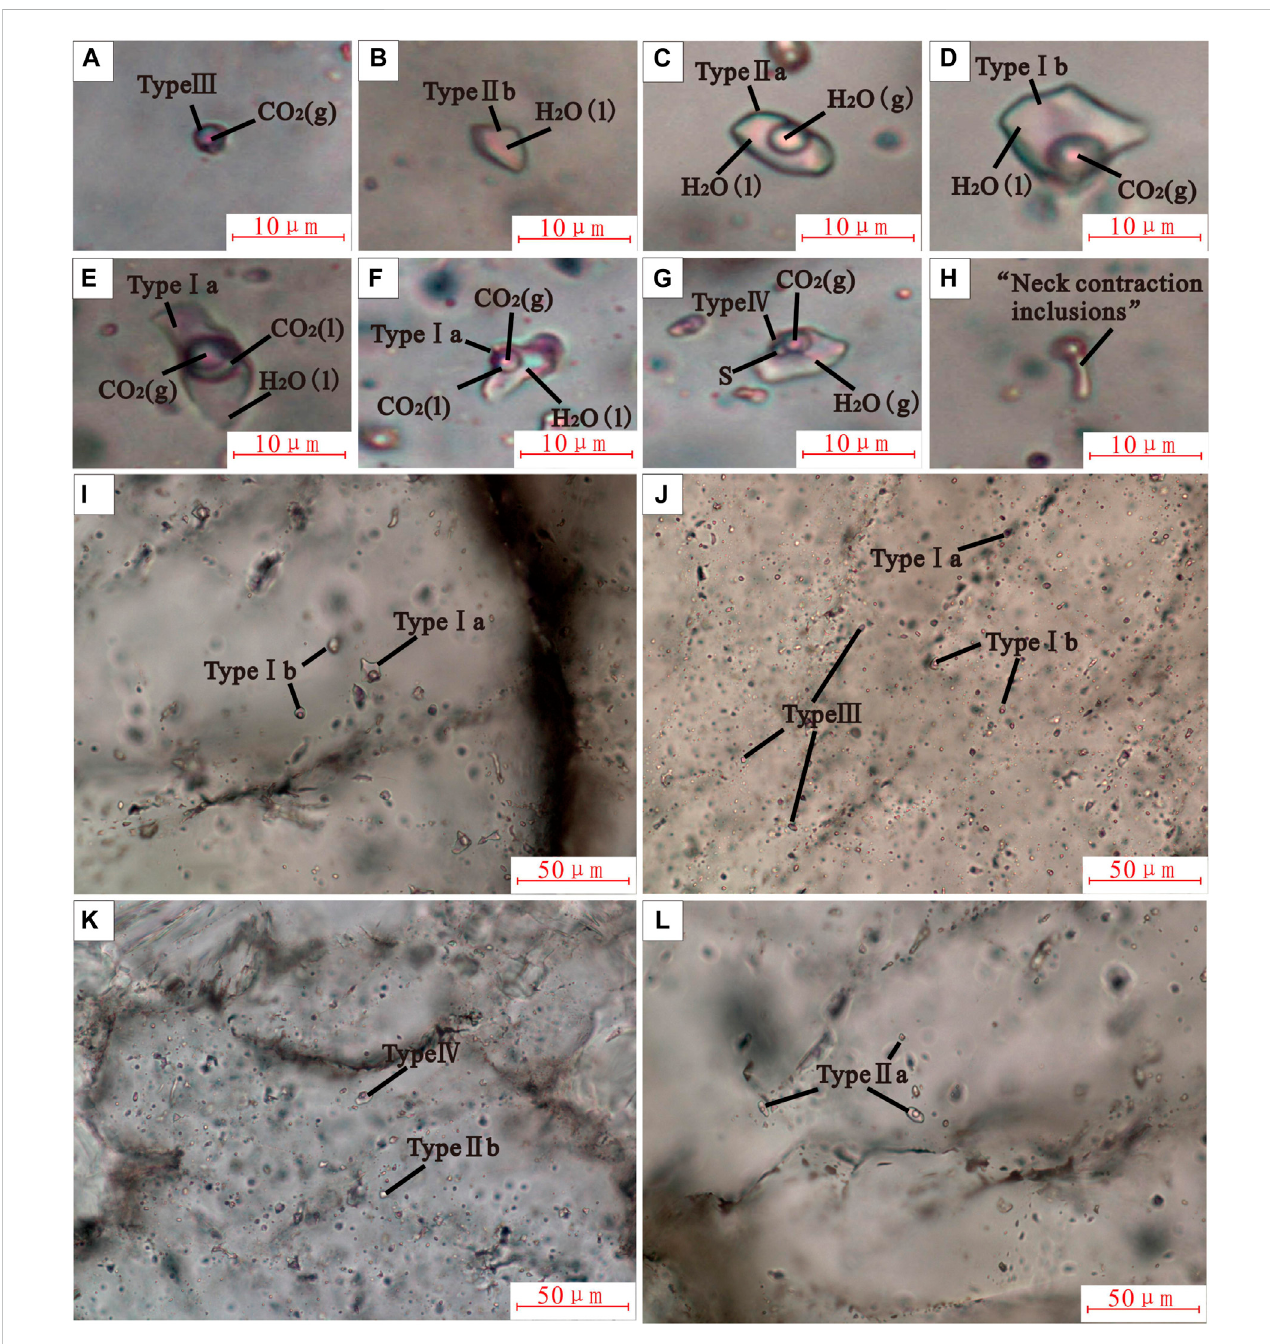
FIGURE 7 Photomicrographs of ore-stage fl uid inclusions from the Zhaoxian gold deposit: (A) CO 2 single-phase; (B) aqueous single-phase; (C) two-phase aqueous inclusions; (D) two-phase H 2 O + CO 2 inclusions; (E) and (F) three-phase (L H2O + L CO2 + V CO2 ) inclusions; (G) gaseous CO 2 and H 2 O with daughter minerals; (H) neck contraction inclusions; (I) pre-ore-stage inclusions; (J) and (K) syn-ore-stage inclusions; (L) post-ore-stage